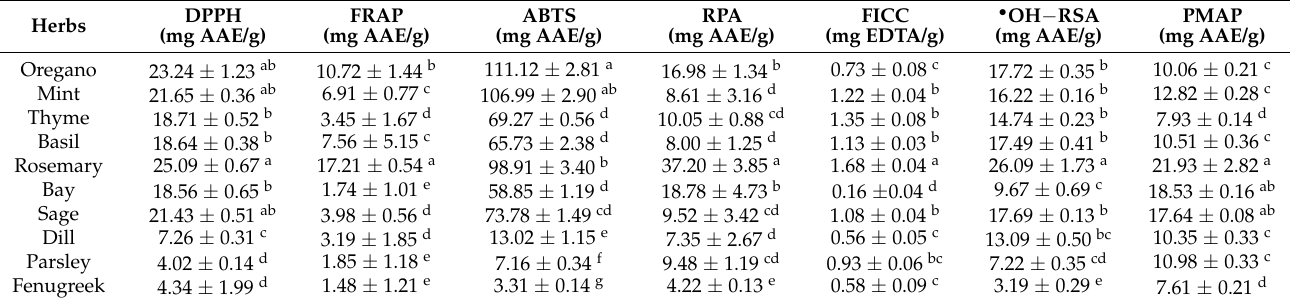
Table 2. Antioxidant activities of 10 widely used